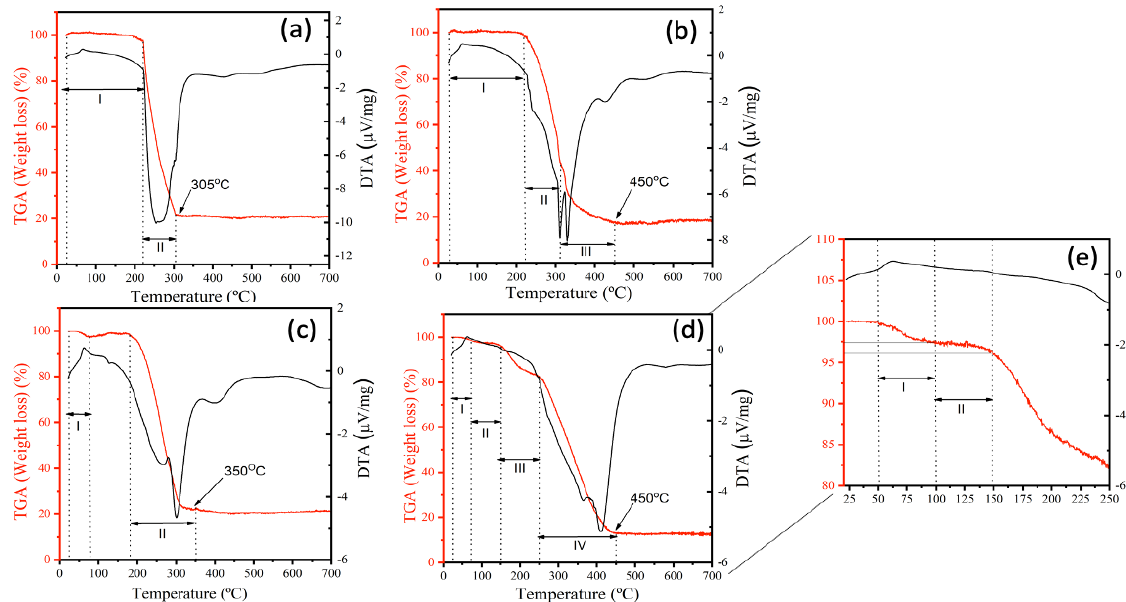
Figure 3. TGA thermograms of the samples for validation obtained from the V1 sample ( a ), the V2 sample ( b ), the V3 sample ( c ), the V4 sample ( d ) and the zoom from 25 to 250 °C ( e ). Table 3. Results of weight-loss ratios for the samples from the validation experiments.